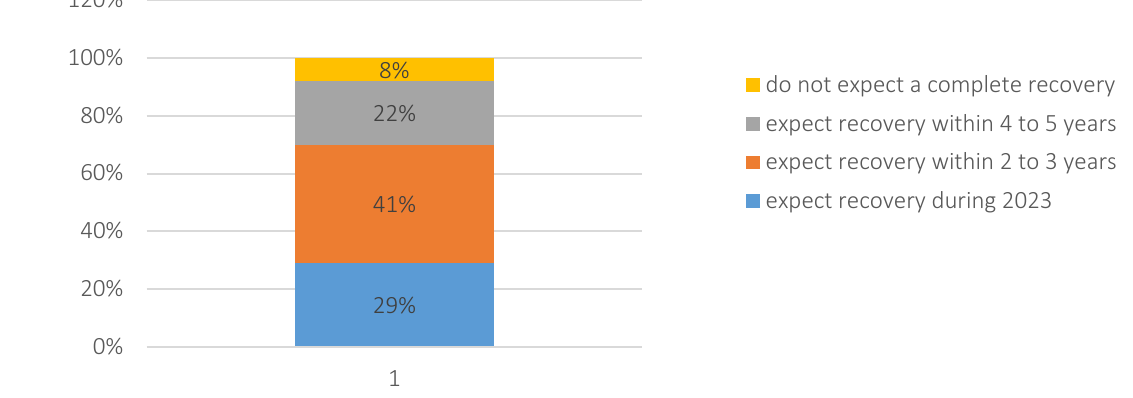
Figure 5. Expectations of the hospitality industry regarding the timing of business